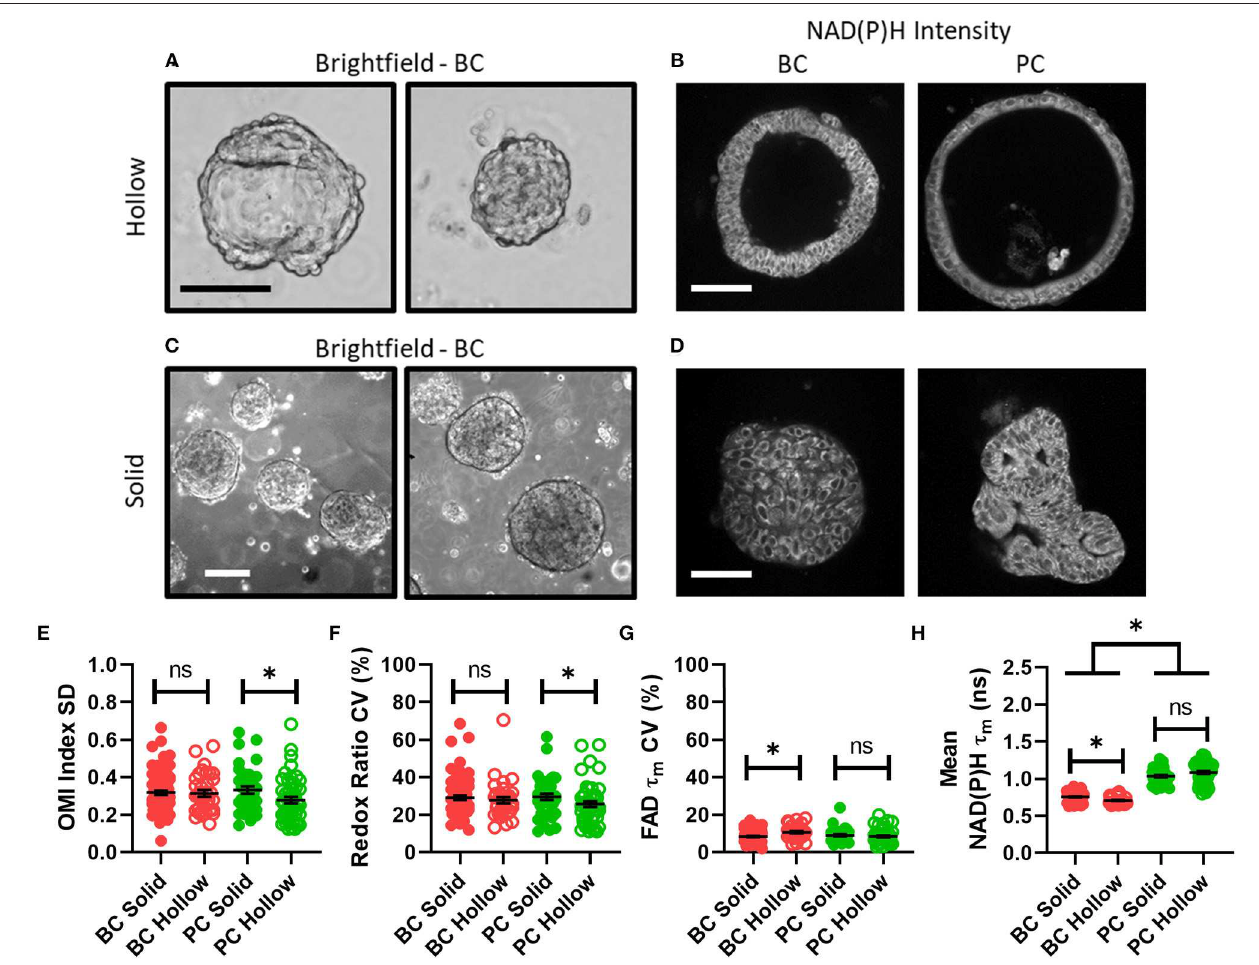
FIGURE 3 | Disparities in metabolism and intra-organoid heterogeneity by morphology and cancer type. (A) Representative brightfield images of hollow breast cancer organoids. Scale bar = 100 µ m. (B) Representative NAD(P)H intensity images of hollow breast and pancreatic cancer organoids. Scale bar = 100 µ m. (C) Representative brightfield images of solid breast cancer organoids. Scale bar = 250 µ m. (D) Representative NAD(P)H intensity images of solid breast and pancreatic cancer organoids. Scale bar = 100 µ m. (E–H) The intra-organoid standard deviation of the OMI index (E) , coefficient of variation of the redox ratio (F) , coefficient of variation of mean fluorescence lifetime of FAD (G) , and the mean fluorescence lifetime of NAD(P)H (H) for cells within hollow vs. solid organoids. * p < 0.05. Each dot represents one organoid (mean ±